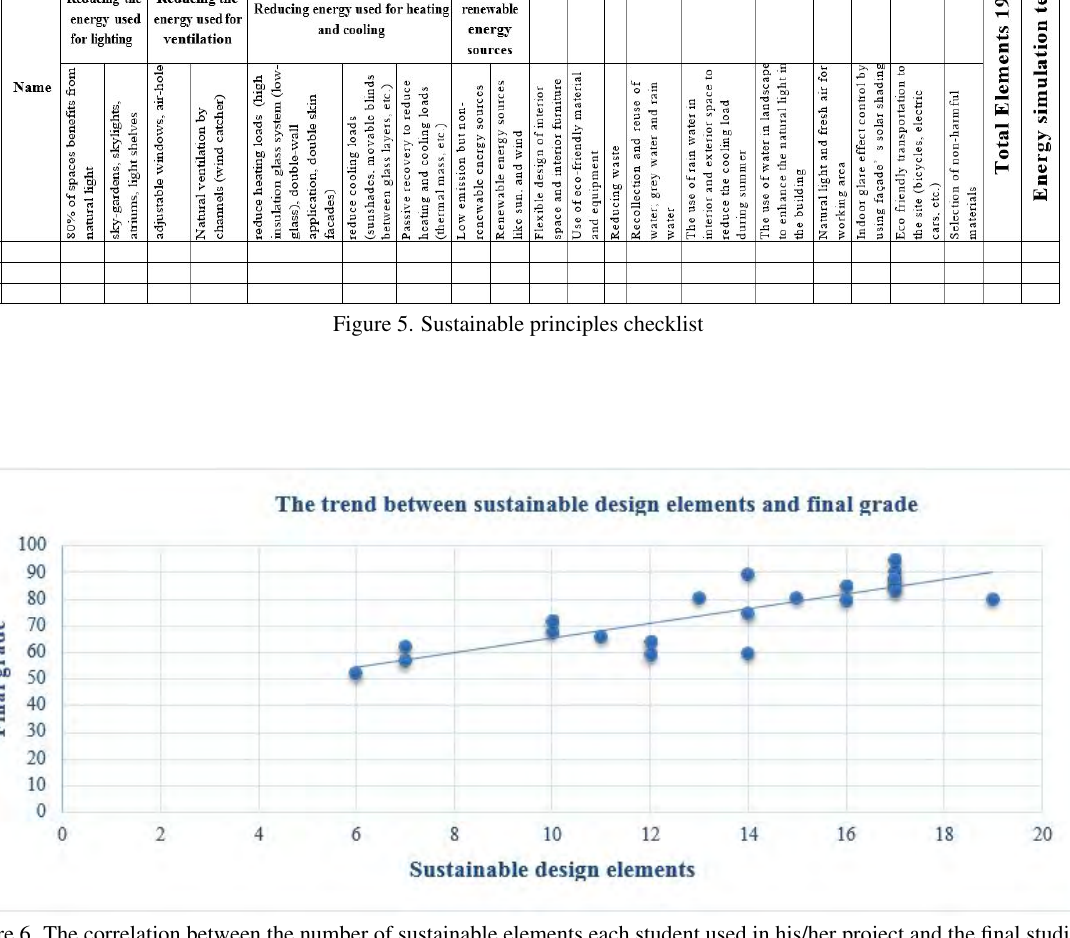
Figure 6. The correlation between the number of sustainable elements each student used in his/her project and the final studio grade